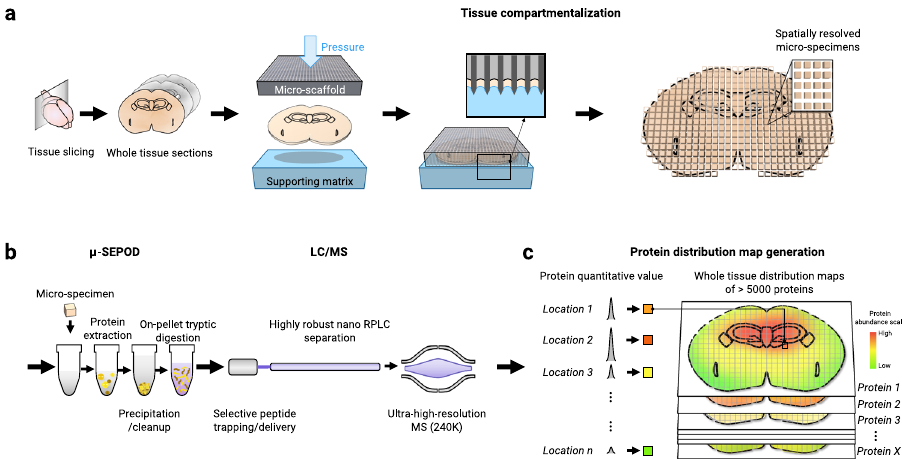
Fig.1|SchemeoftheMASPstrategywhichenablesaccurate,quantitative,and in-depth protein mapping across a whole tissue slice. a Robust tissue micro- compartmentalization with precisely-preserved spatial information, by a 3D- printed micro-scaffold. b Ef fi cient/reproducible preparation of the location- speci fi c micro-specimens (micro-surfactant-aided extraction/precipitation/on-pel- let digestion, µ -SEPOD) followed by robust/sensitive LC-MS analysis. c Protein